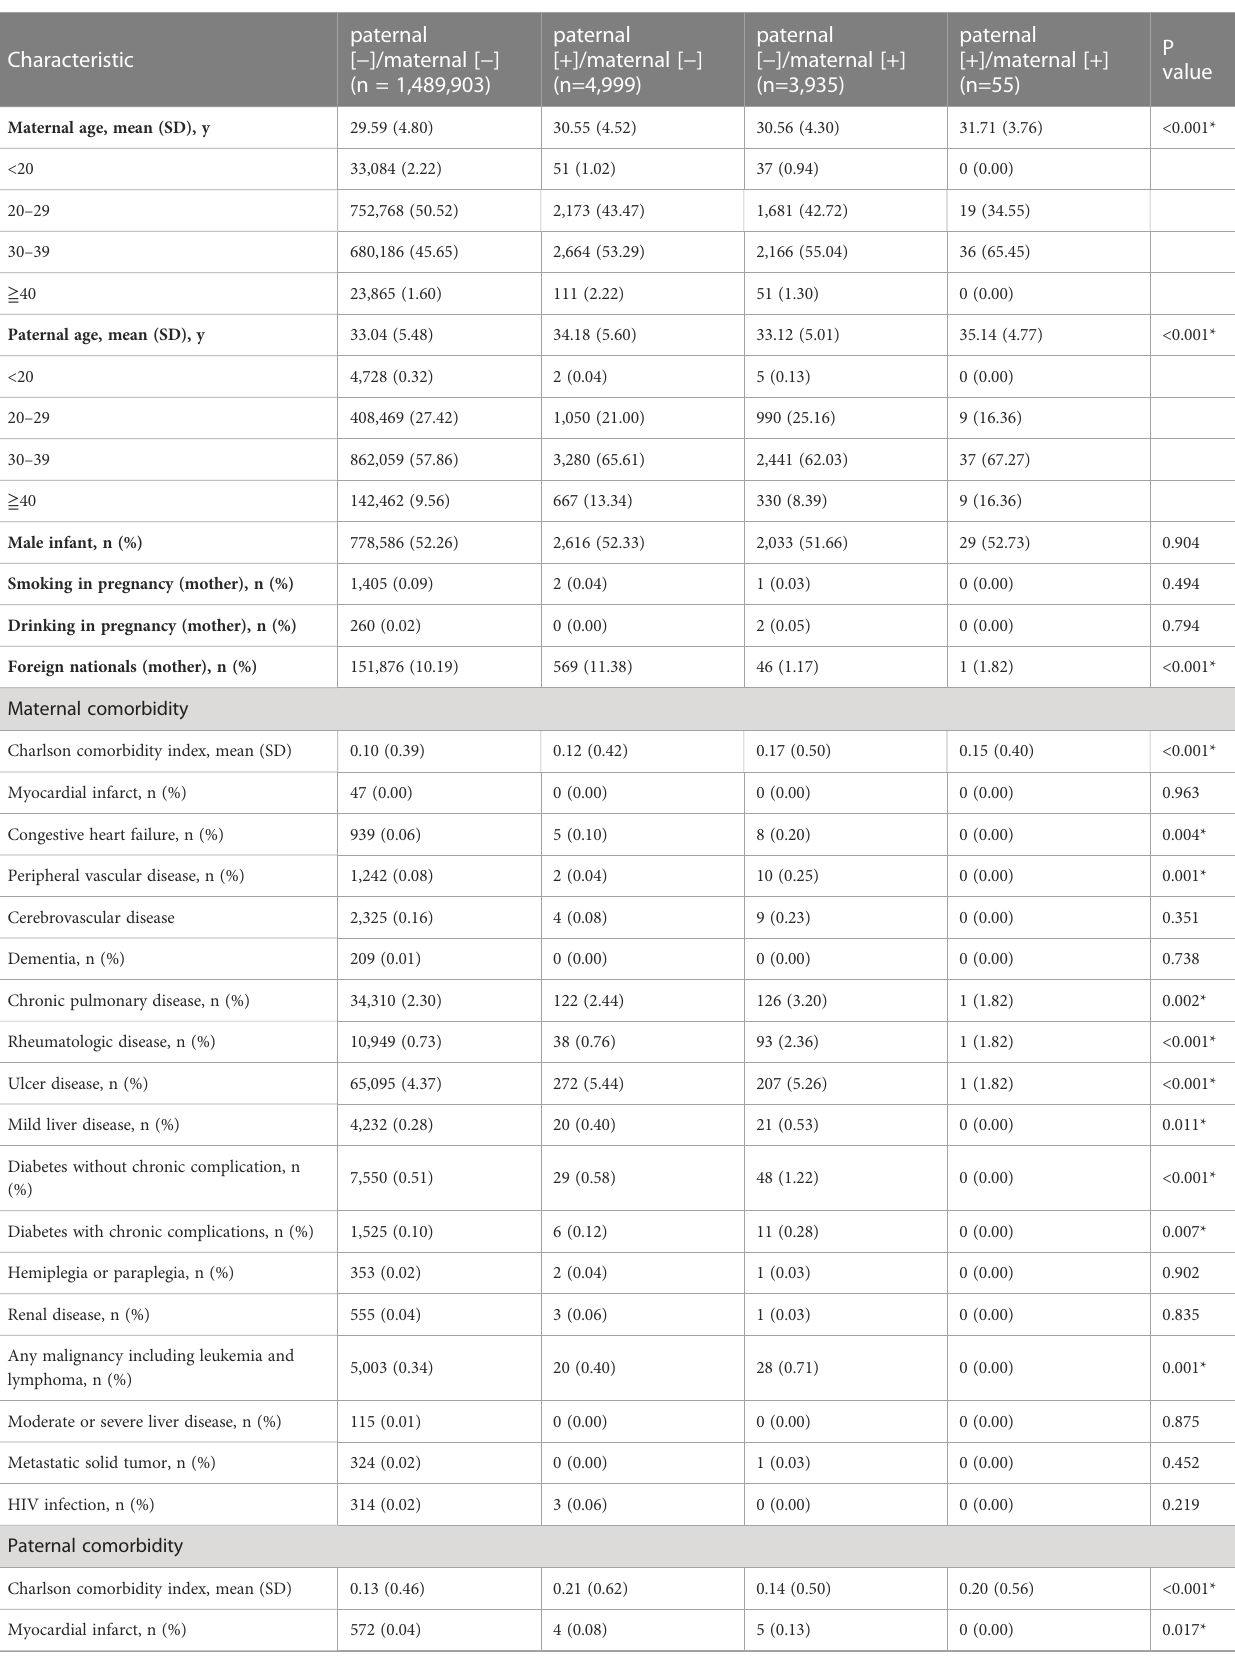
TABLE 1 Baseline demographic and clinical characteristics of pregnancies between parents with or without psoriasis.